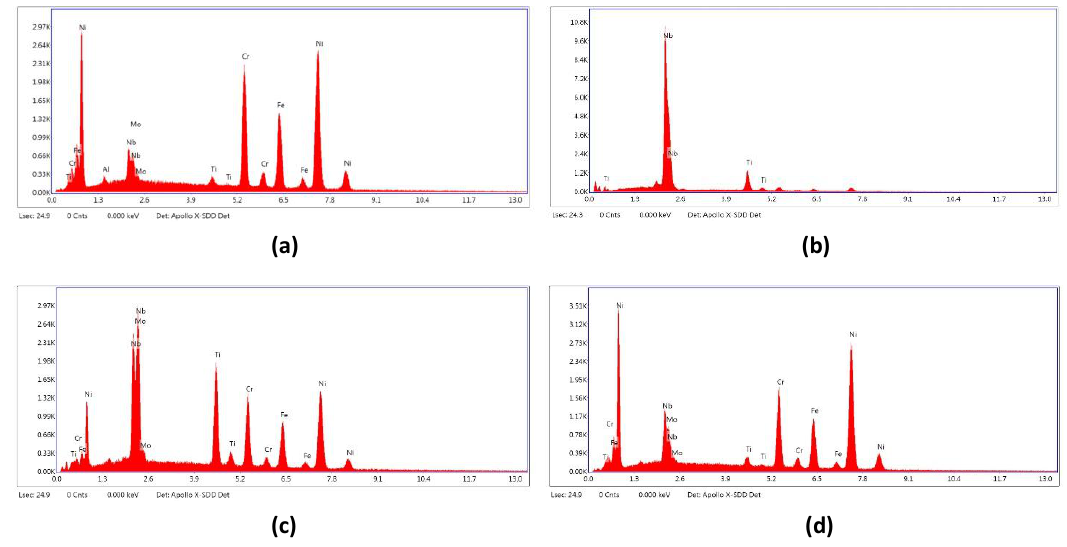
Figure 9. EDS spectra for the ( a ) 𝛾 , ( b ) MC-type carbide, ( c ) δ, and ( d ) Laves phases.